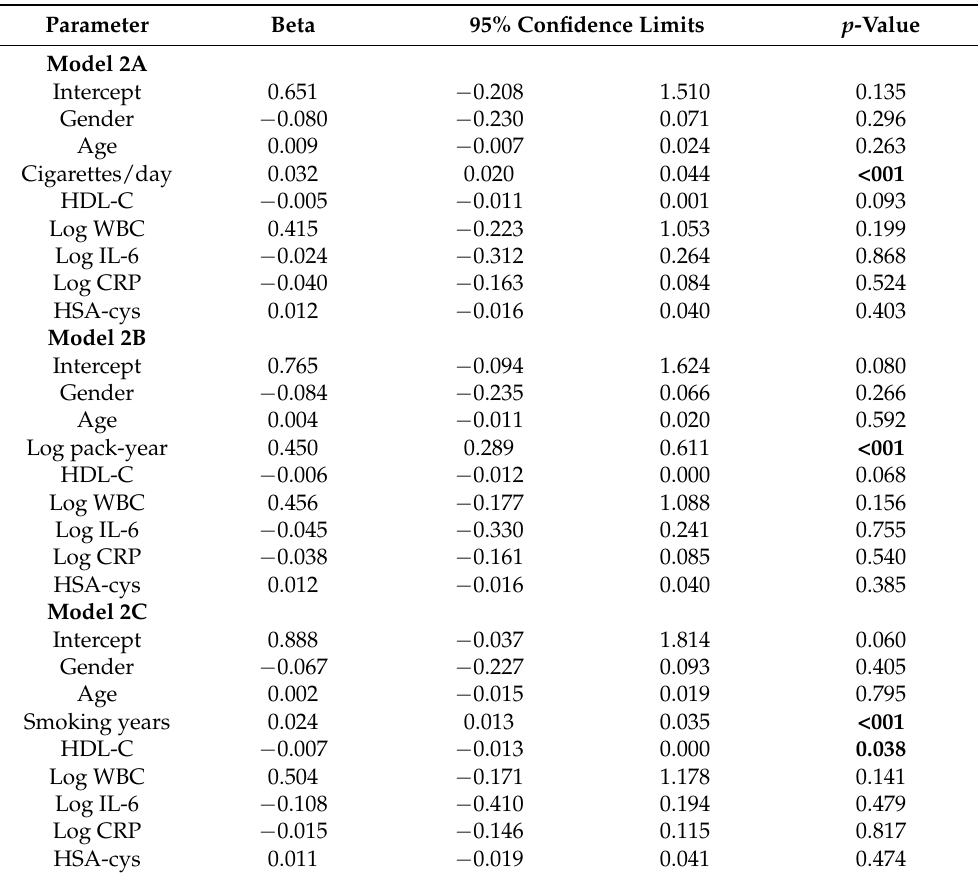
Table 3. General linear models generated considering HDL-SPB as dependent variable taking into consideration inflammatory and oxidative stress markers (Model 2 described in Methods section). In addition, model 2A considers cigarettes/day, model 2B pack-years, and model 2C smoking years as independent